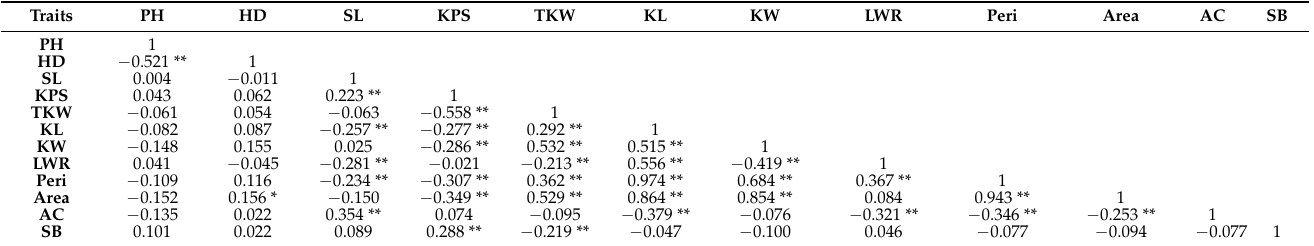
Table 2. Correlation analysis of different traits based on